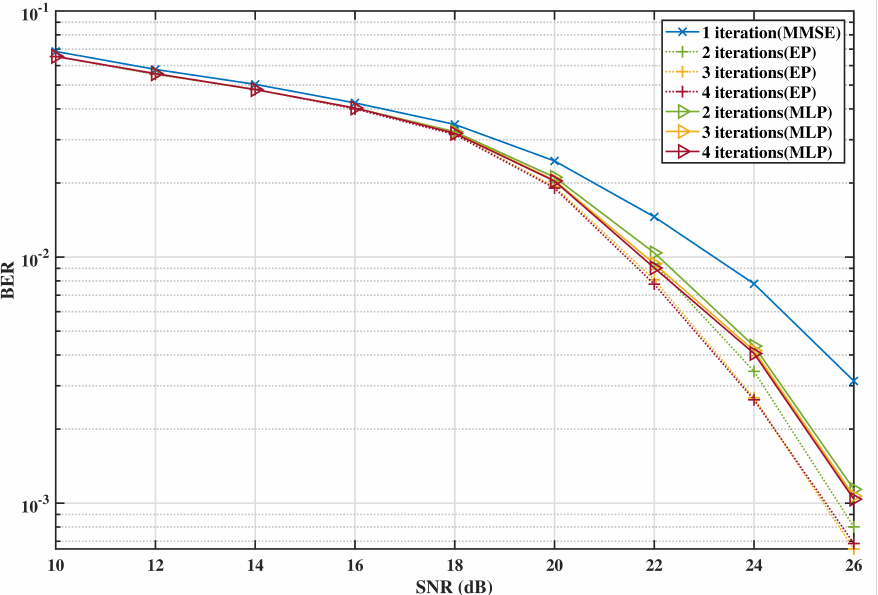
Figure 5. BER performance for the case of the correlated Rayleigh fading MIMO channel scenario scenarios with n = 4, m = 8, and 256-QAM constellation.